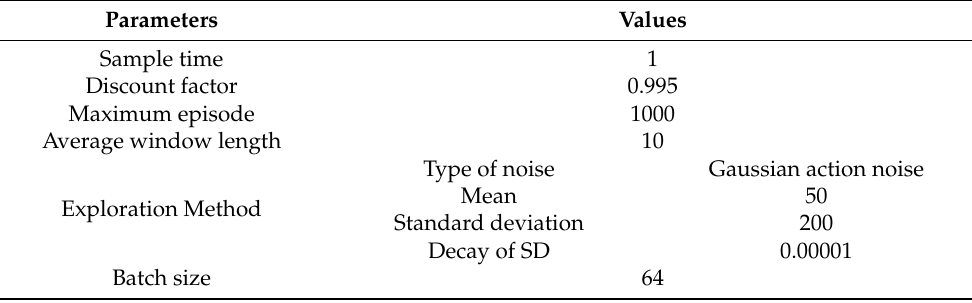
Table 6. Parameters settings for reinforcement